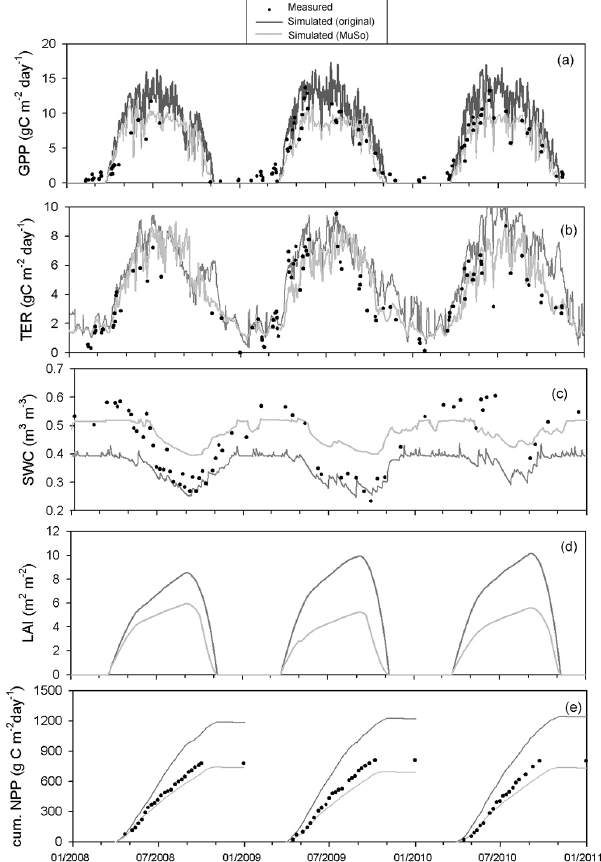
Figure 7. Measured (black dots) and simulated variables (a) GPP, (b) TER, (c) SWC, (d) LAI, (e) abgC using original Biome-BGC (dark grey lines) and BBGCMuSo (light grey lines) models for maize simulation at the Mead1 site between 2003 and